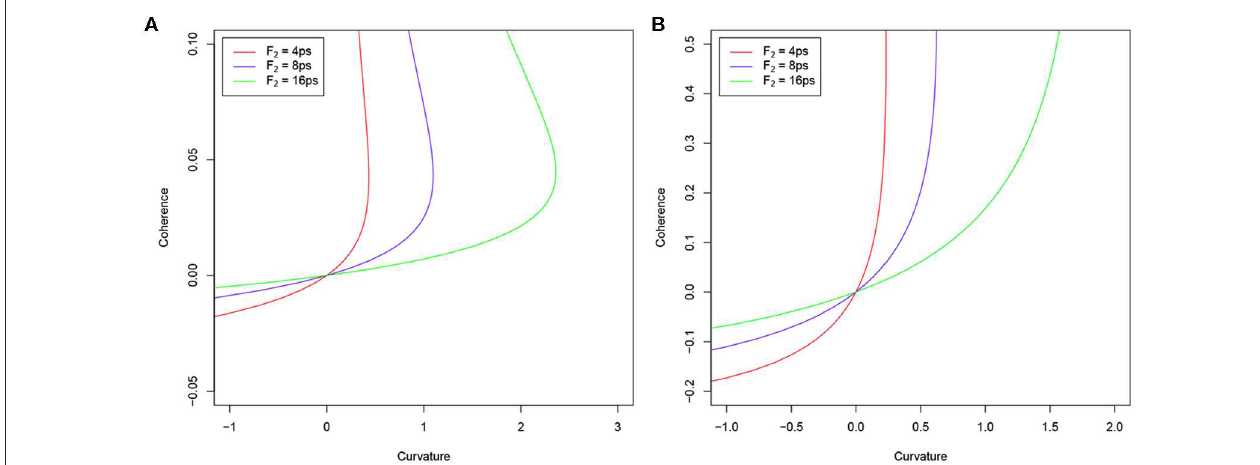
16 ps , respectively. (A) =